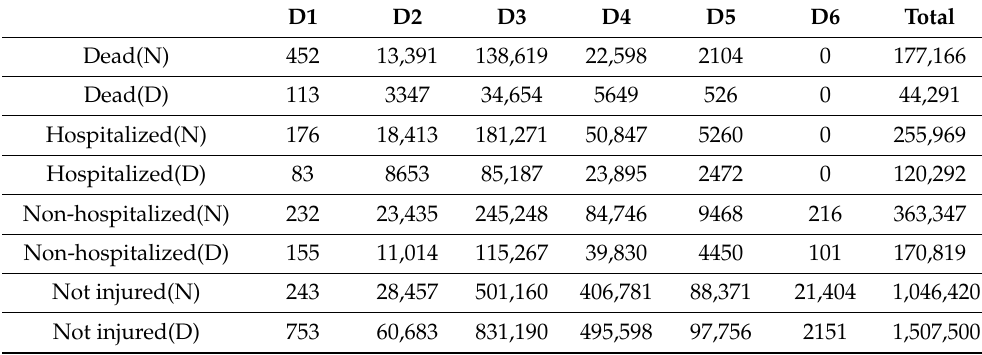
Table 19. Mortality rate in Tabriz city for the 1780